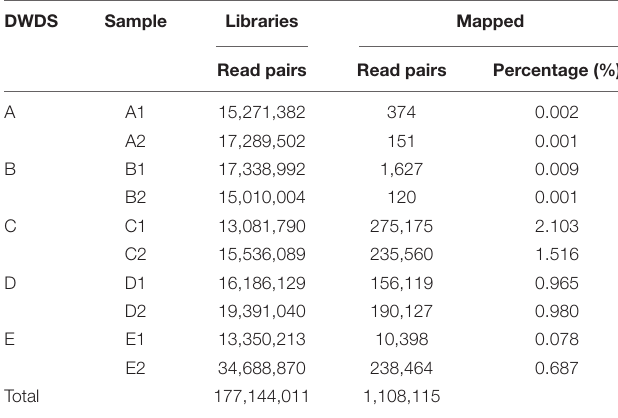
TABLE 2 | Count abundance and proportion of reads mapped to ARG and MRG present in DWDSs A–E metagenomic libraries obtained with